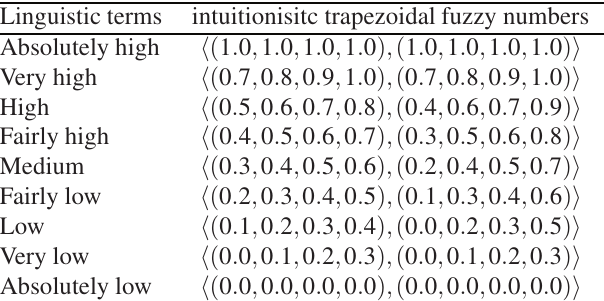
Table 1. Linguistic values e.g. (Ref. 30) (determined by de- cision maker’s experience) of intuitionistic trapezoidal fuzzy numbers (ITFN) for linguistic terms. Linguistic terms intuitionisitc trapezoidal fuzzy